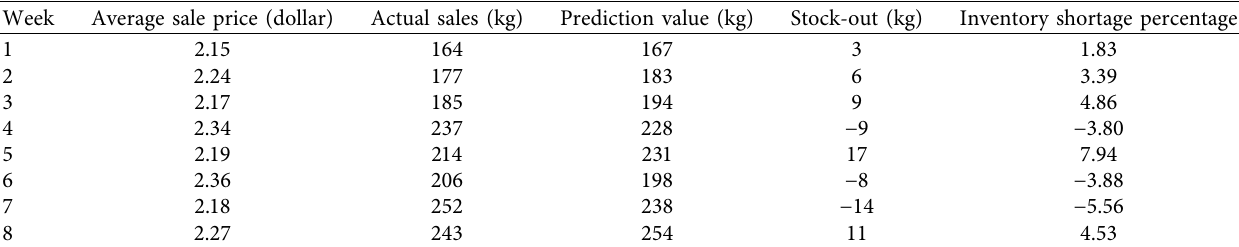
Table 4: Actual sales and forecast value of online consumption demand of egg in 8 weeks.